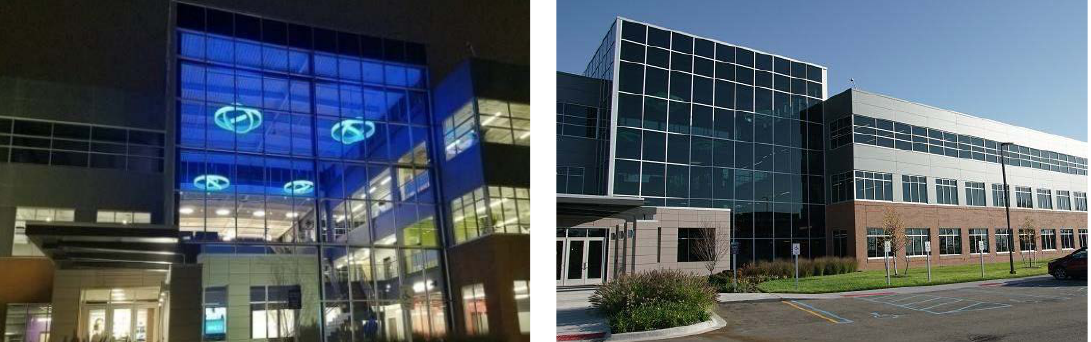
Figure 3 Trasparent and tinted states of thermochromic smart window in Masco Building facade